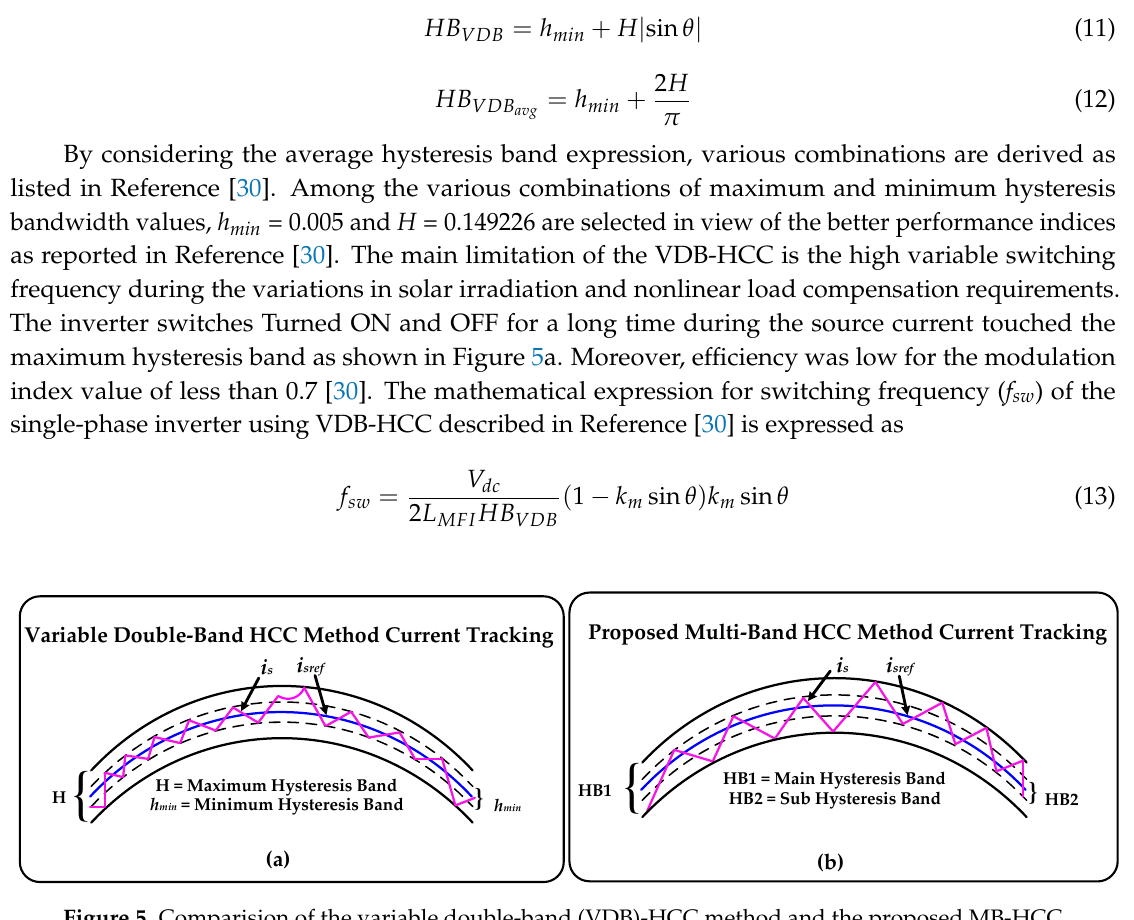
Figure 5. Comparision of the variable double-band (VDB)-HCC method and the proposed MB-HCC method current tracking; ( a ) VDB-HCC current tracking; ( b ) MB-HCC current tracking.